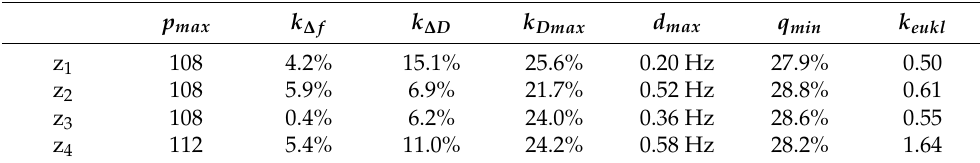
Table 6. Found values of the hyperparameters (see Table 1) in the Bayesian optimization step for different WPT